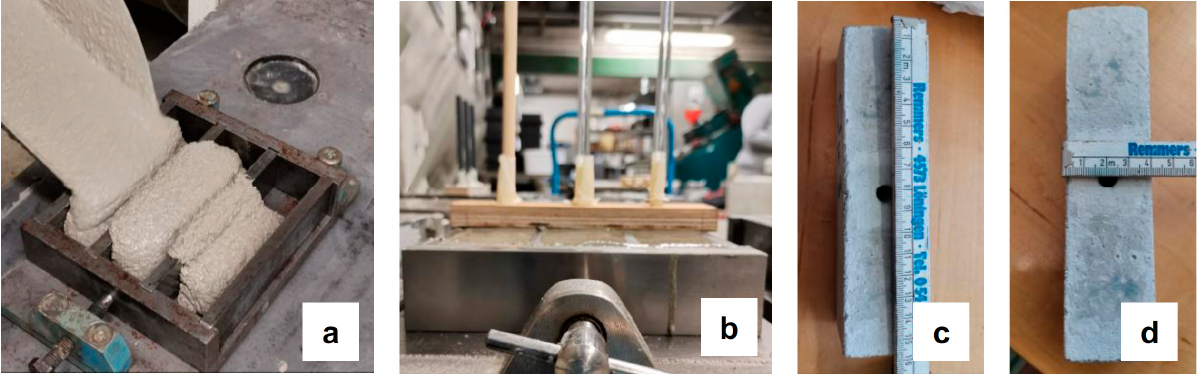
Figure 2. ( a ): Manufacture of test specimen; ( b ) tubes as placeholders for humidity sensors; ( c , d ): mortar prism with recess for humidity sensors.